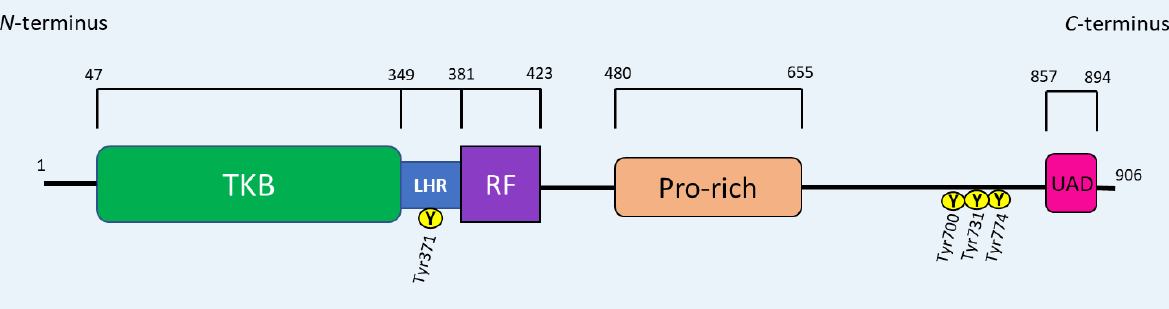
Figure 12. Schematic drawing representing the structure of the Casitas B-lineage lymphoma (c-CBL) protein.